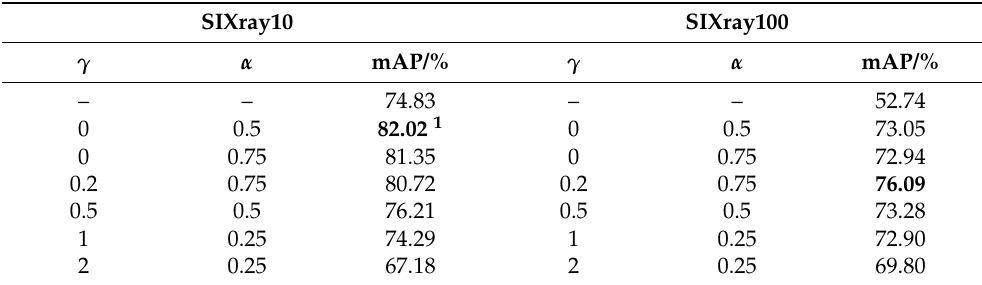
Table 3. Effect of varying parameters setting to model performance on SIXray10 and SIXray100 subsets. First row with symbol “–” shows the performance result on baseline.